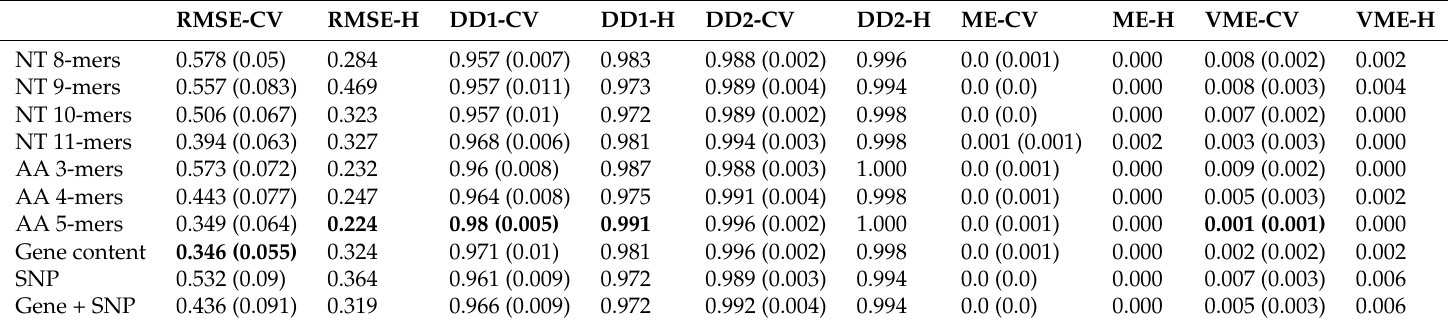
Table A64. S. enterica